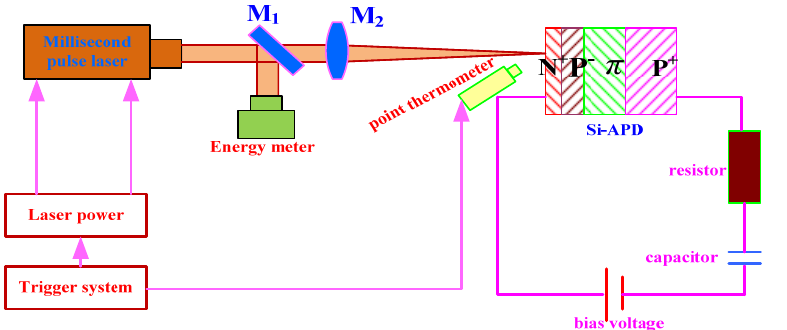
Figure 1. Experimental device.